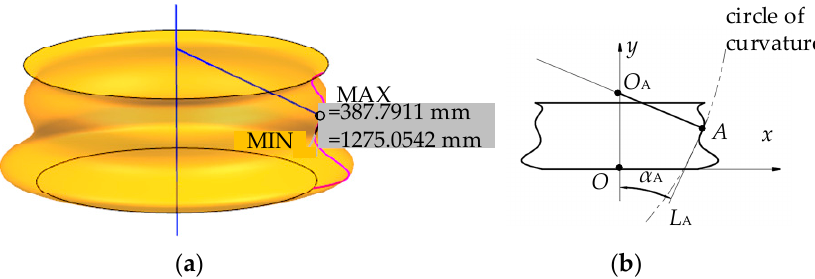
Figure A1. The extreme value of the radius of curvature at any point on arbitrary curve rotation surface. ( a ) Three-dimensional model of arbitrary curve rotation; ( b ) Cross-sectional view of arbitrary curve rotation.